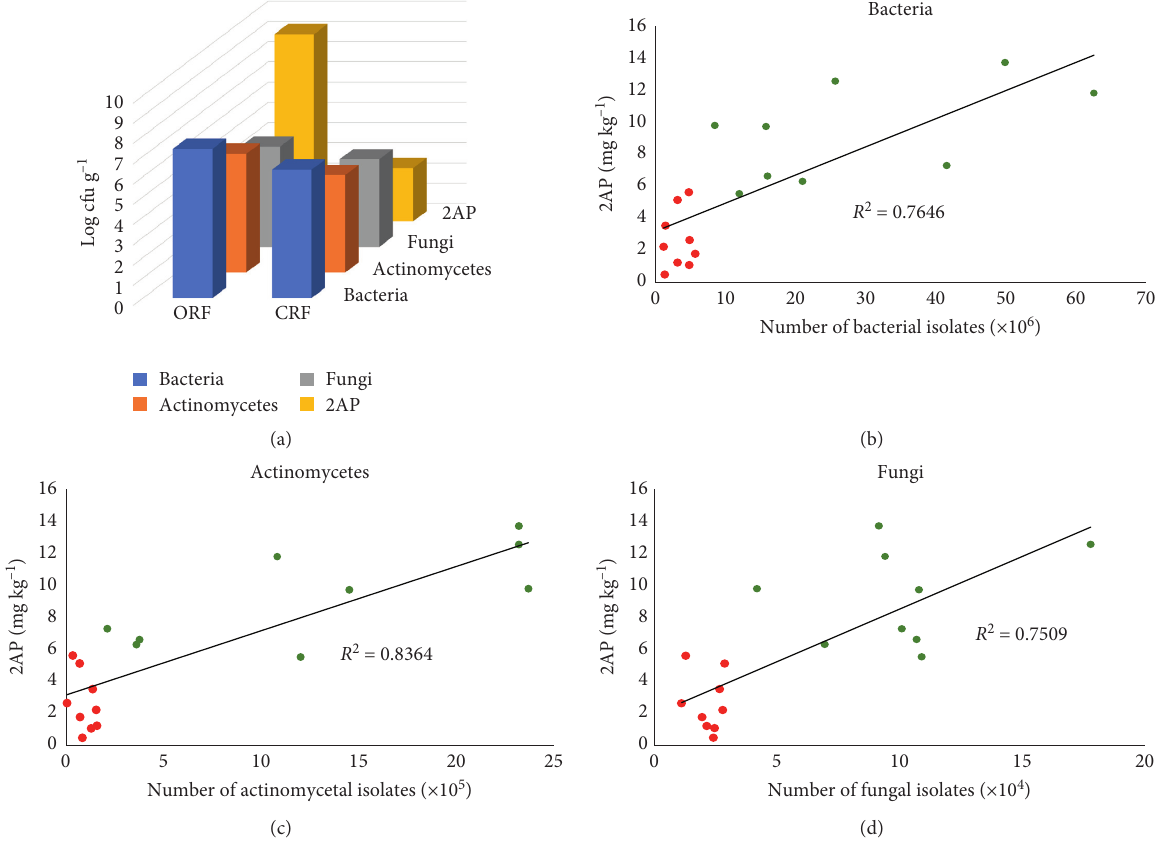
Figure 11: Influence of soil microbial populations on the 2-acetyl-1-pyrroline (2AP) content in Khao Dawk Mali 105 (KDML105) rice grains (a) and their relationship with the 2AP content (b), (c), and (d). Note: ORF � organic rice farming; CRF � conventional rice farming.